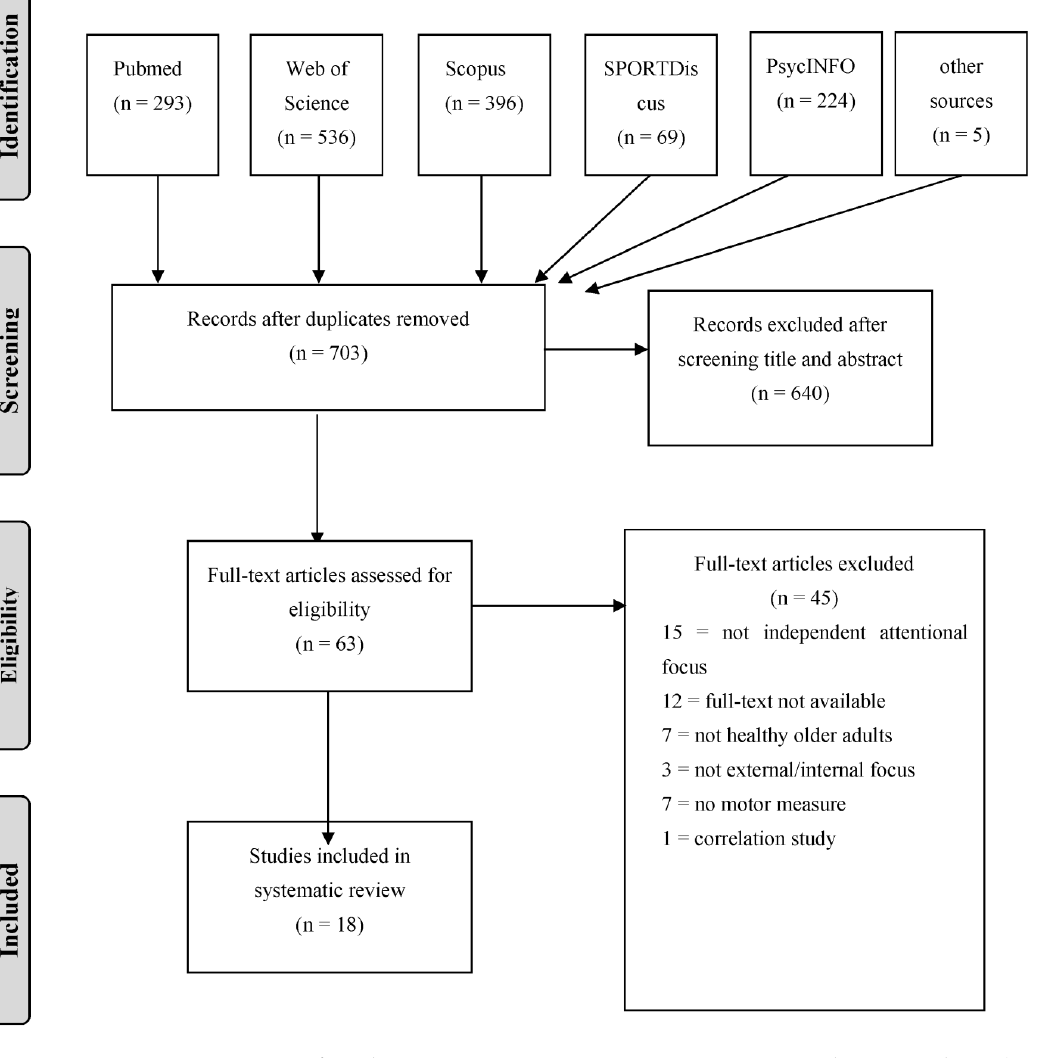
Figure 1. Preferred Reporting Items in Systematic Reviews and Meta-analyses (PRISMA) flow diagram for selecting the studies .